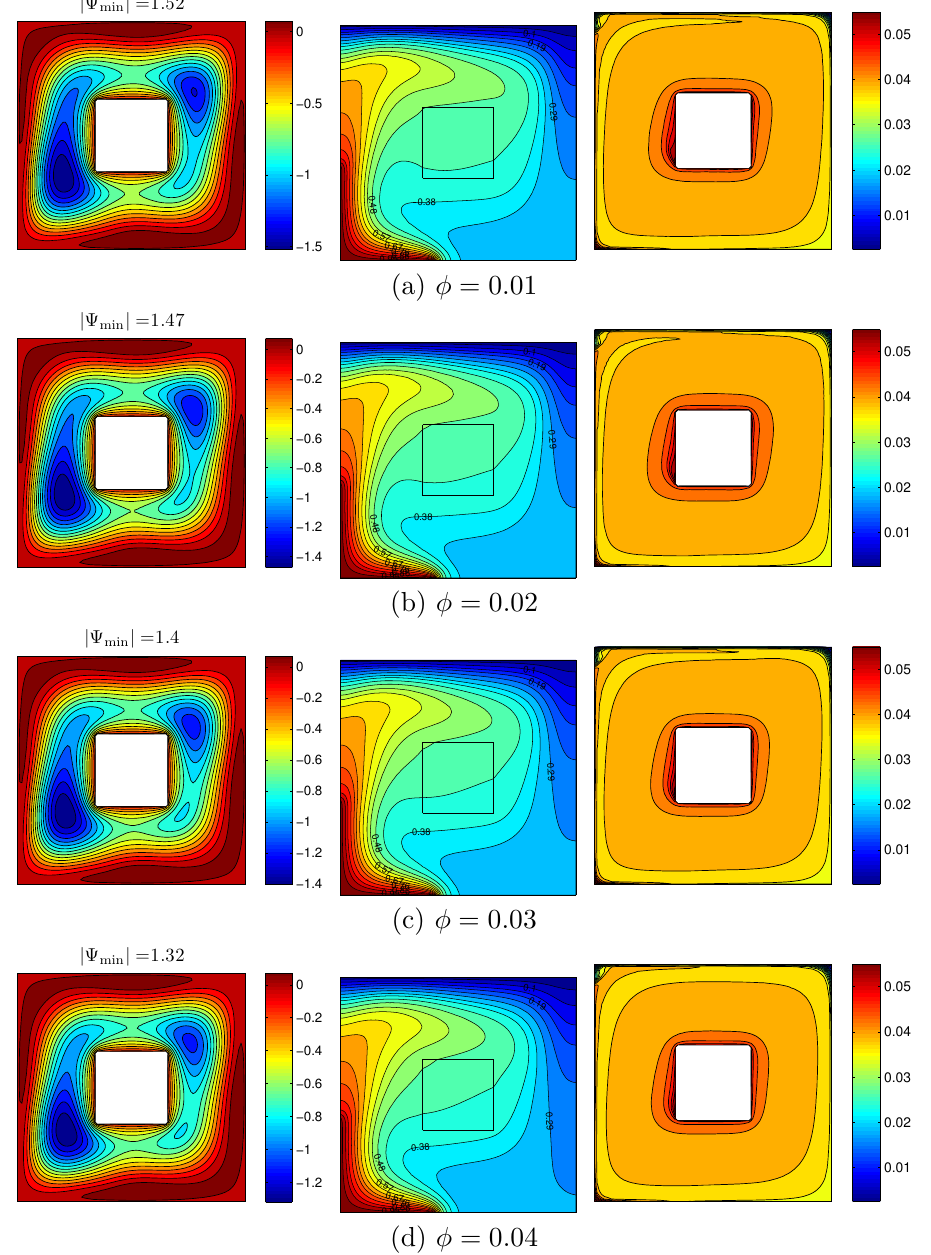
Figure 6. Variations of the streamlines ( left ), isotherms ( middle ), and nanoparticle distribution ( right ) evolution by solid volume fraction ( φ ) for Ra = 10 5 , k w = 0.76 and D = 0.3. ( a ) φ = 0.01; ( b ) φ = 0.02; ( c ) φ = 0.03; ( d ) φ =